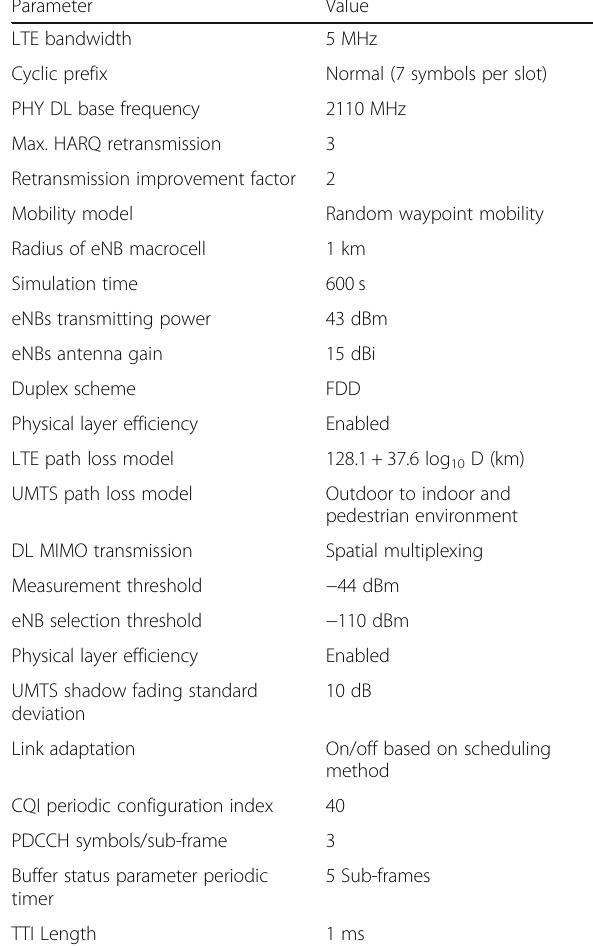
Table 7 Wireless network configuration parameters